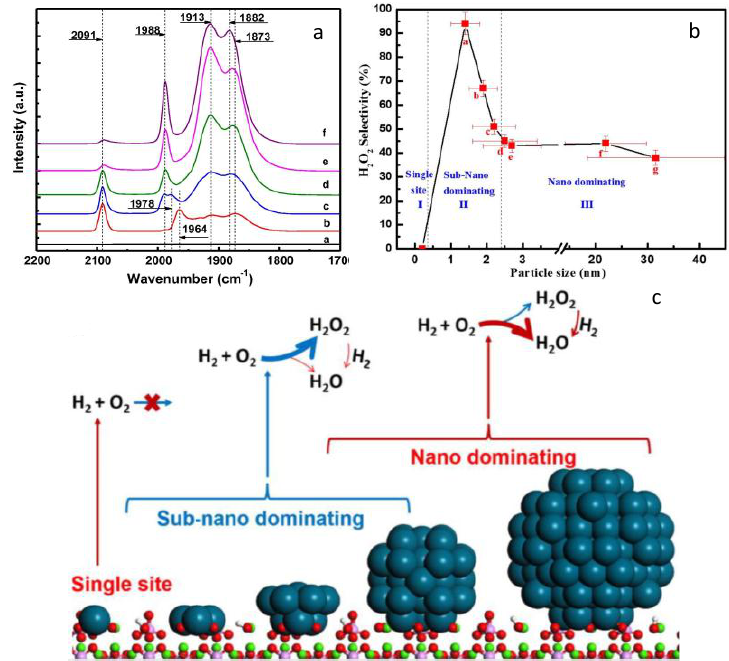
Figure 8. ( a ) In situ DRIFTS of CO adsorption over different catalysts at 283 K in an Ar flow (50